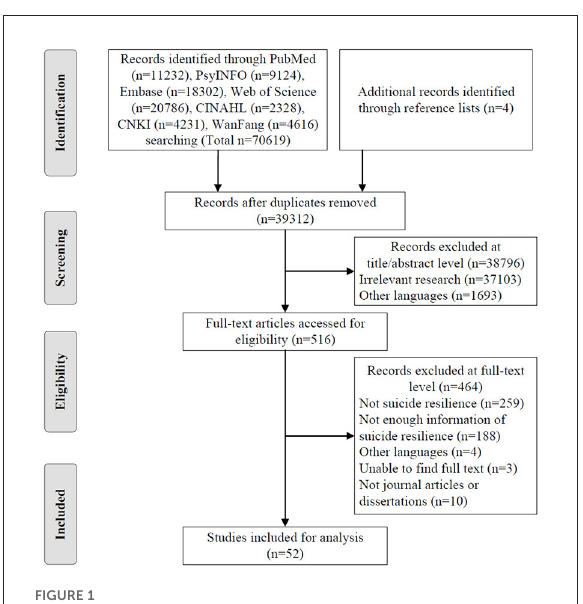
FIGURE1 PRISMA literature search